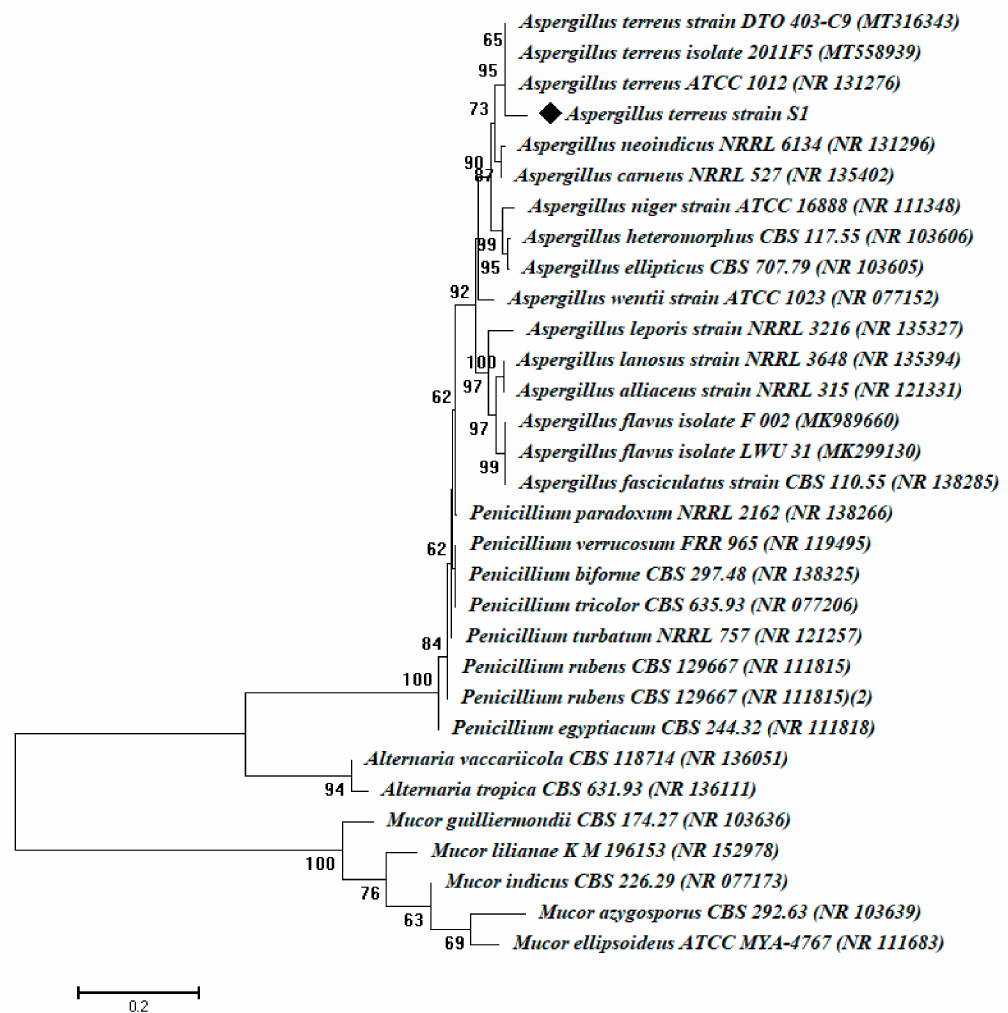
Figure 1. Phylogenetic tree of the fungal strain S1 with the sequences from NCBI. The symbol (cid:7) refers to ITS fragments retrieved from this study. The tree was constructed with MEGA 6.1 using the neighbor-joining